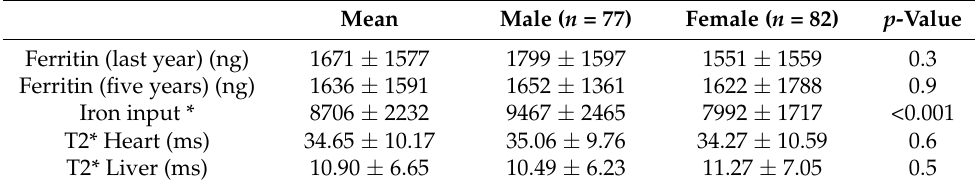
Table 4. Iron related